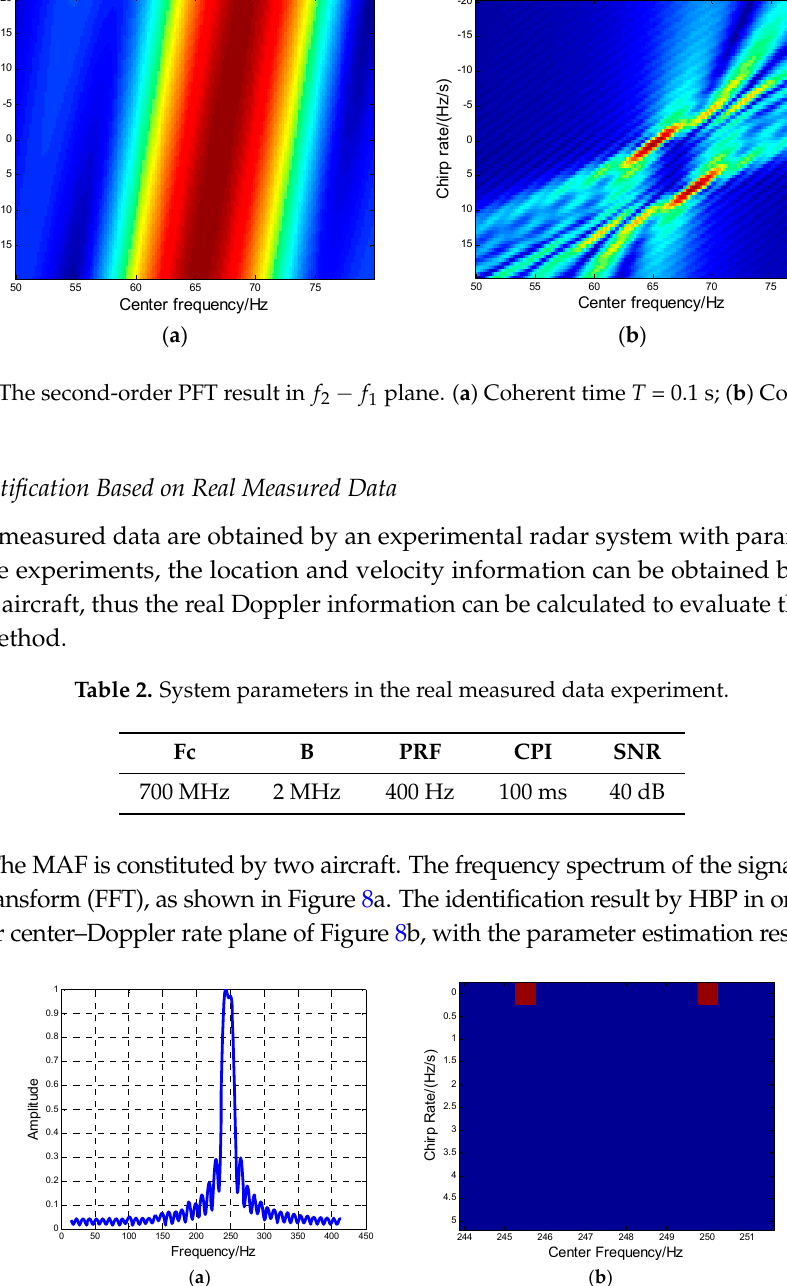
Figure 8. The two-aircraft MAF identification result. ( a ) Frequency spectrum of the MAF formation; ( b ) The MAF identification result by HBP.